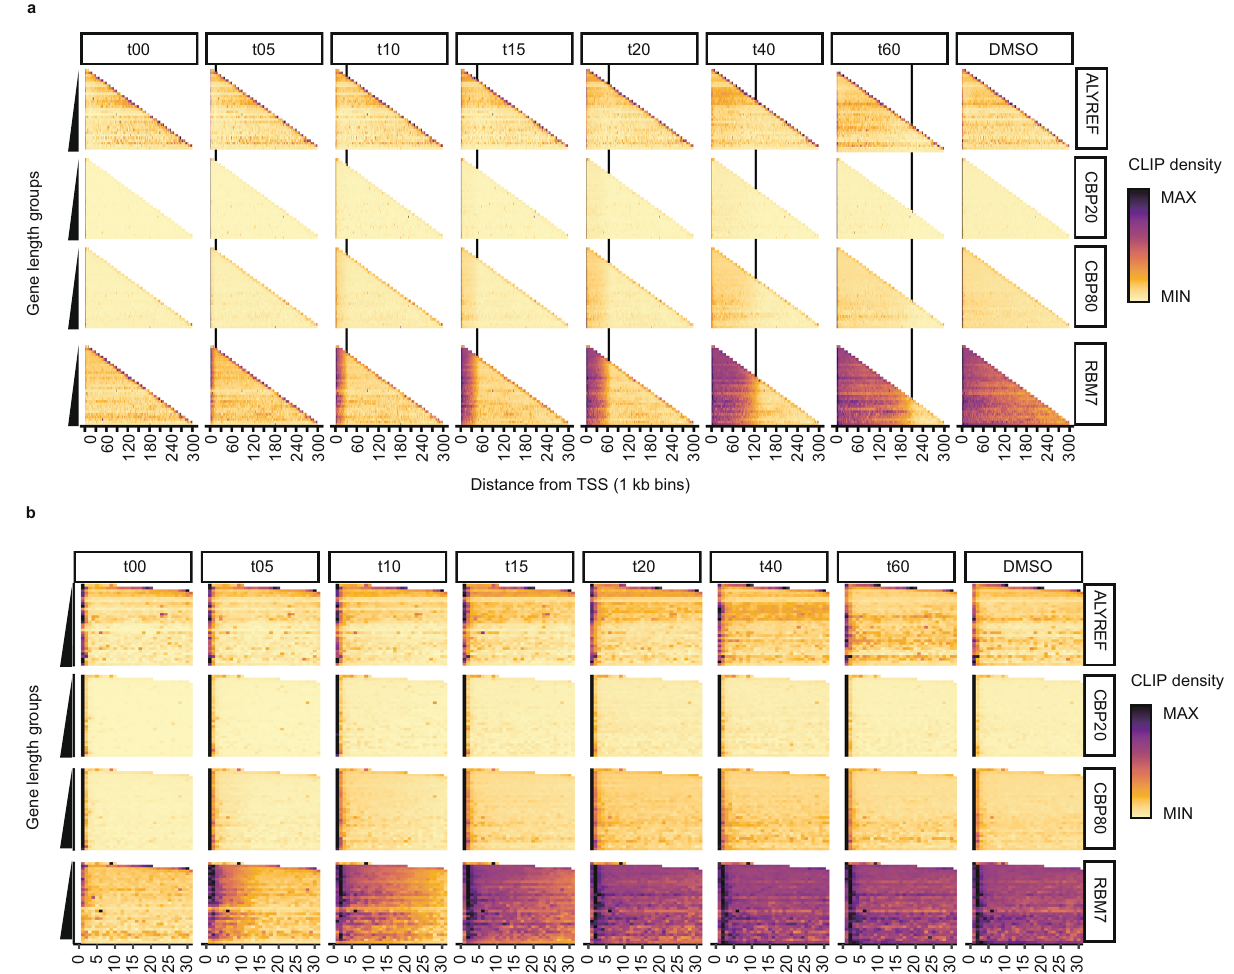
Fig. 2 | Spatiotemporal RNA binding of the CBC, ALYREF and RBM7 is dictated byRNAPIItranscription.a SpatiotemporalheatmapsofallTUsgeneratedusingall tiCLIPreads.ThevaluesforeachTUlengthgroupwerenormalisedtothemaxvalue within the same gene length group. Each bin represents 1kb. Black vertical lines